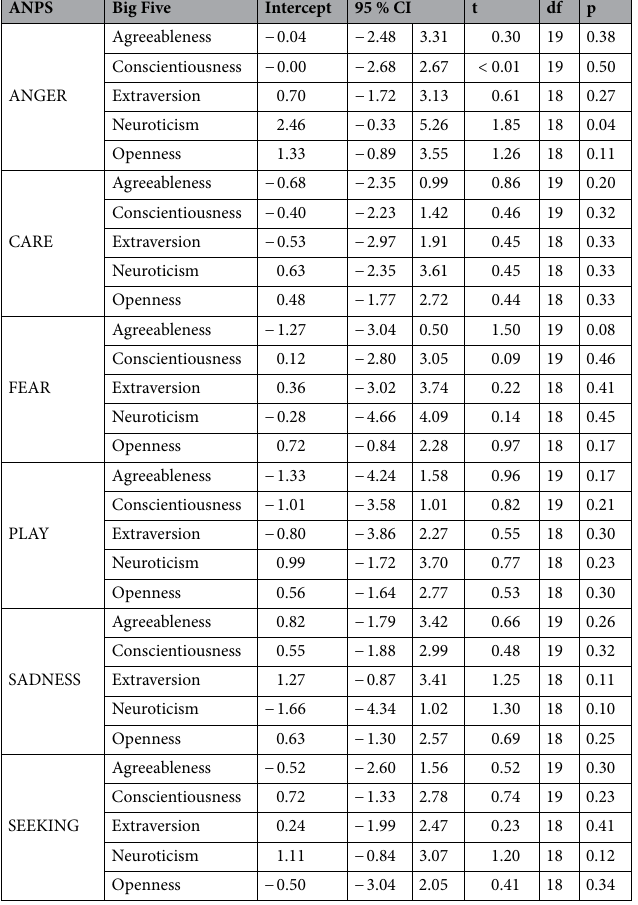
Table 4. Publication bias analyses: Egger’s regression test for funnel plot